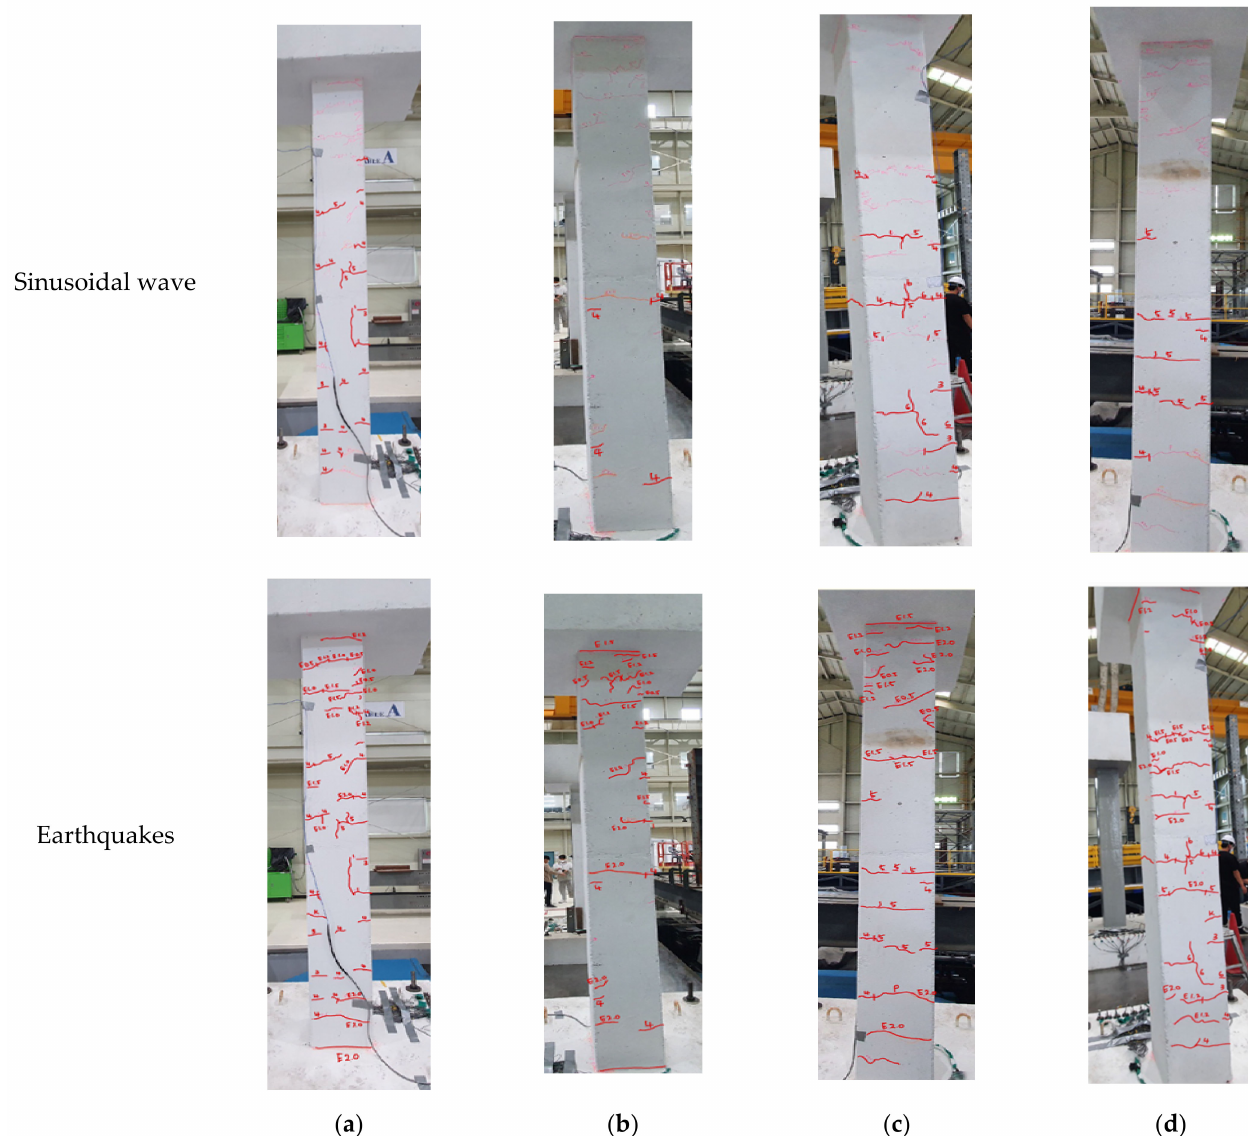
Figure 12. Crack patterns of the unreinforced specimen: ( a ) front view, ( b ) back view, ( c ) right-side view, ( d ) left-side